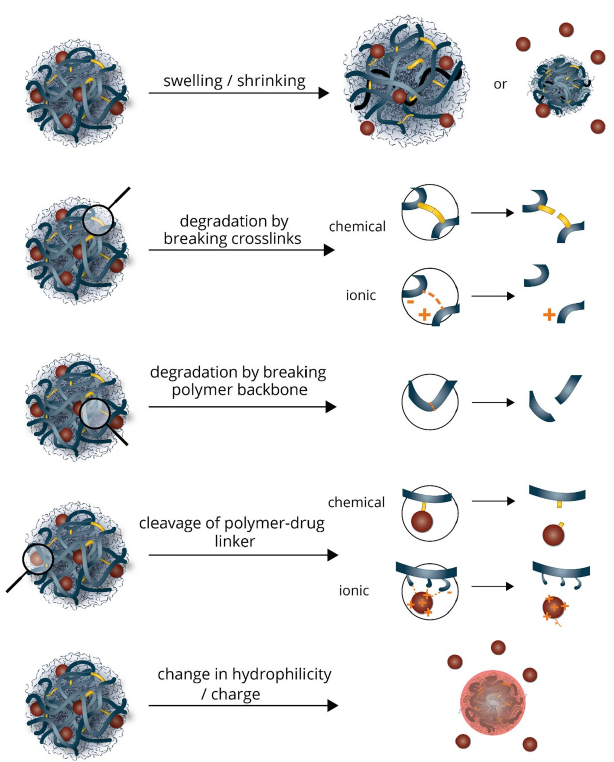
Figure 3. Illustration of the varied stimuli-responsive swelling mechanisms occurring within hydro- gels. Adapted with permission from [39]; Published by Elsevier, 2019.